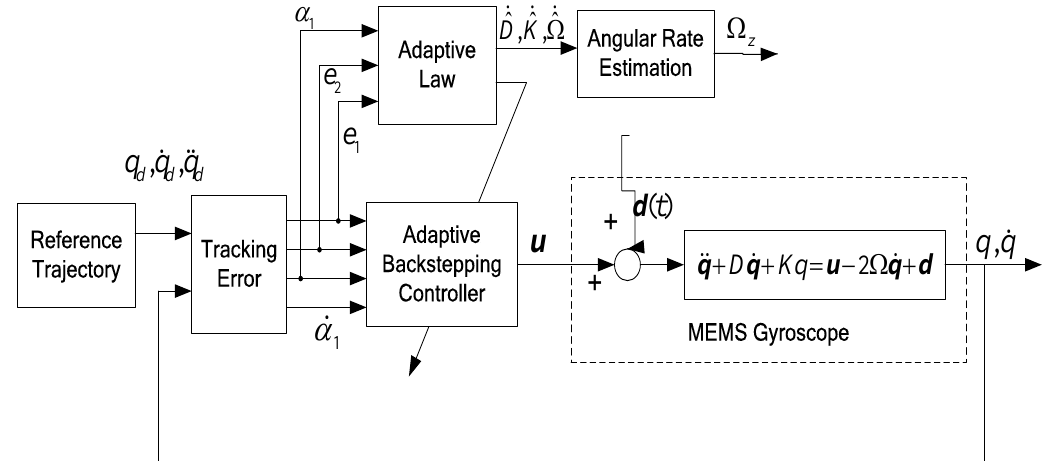
Figure 2. Block diagram of the proposed adaptive backstepping control of a microgyroscope.